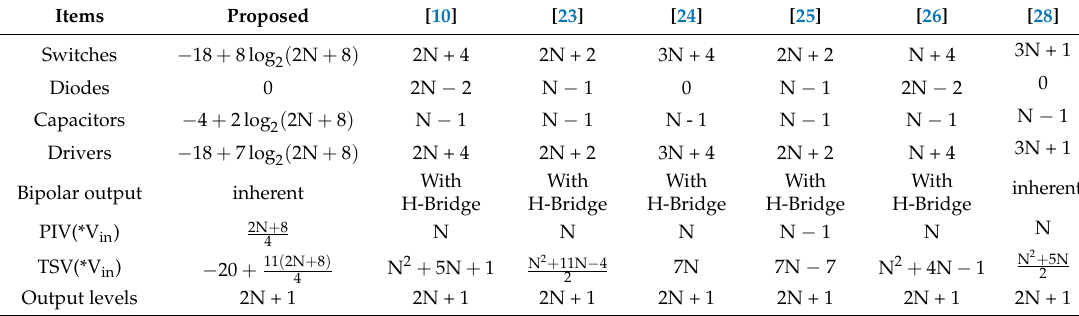
Table 2. Comparison of the Suggested SCMLI with six other topologies for a (2N + 1) level